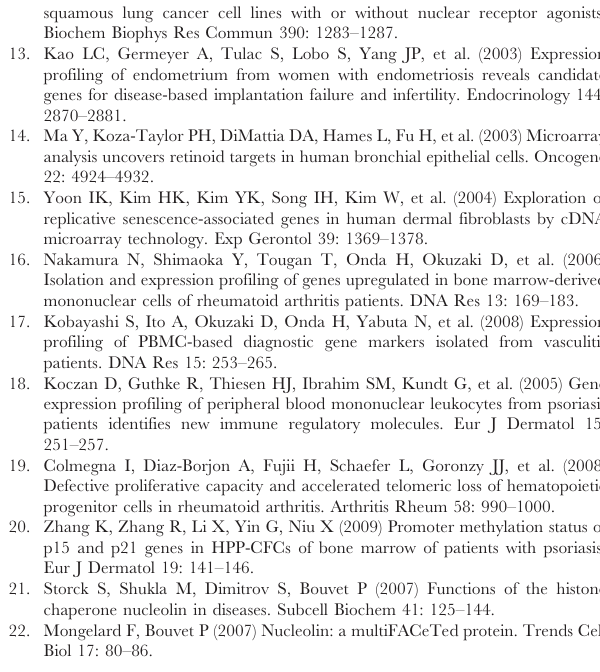
Figure S2 Cell cycle analysis of progenitor cells. LS 2 K cells were sorted from BM transplanted with MIGR1-G0S2 (A) or pSIREN-shG0S2 (B), fixed in 70% ethanol, and stained with Ki67 and 7-AAD ( n = 3–5). *, P , 0.05, and **, P , 0.01 (two-tailed Student’s t -test). Figure S3 Ectopic expression of G0S2 inhibits pro- liferation in EL4 cells and induced perinuclear seques- tration of nucleolin in resting HSCs. (A) Cell growth was analyzed in EL4 cells transduced with retroviruses MIGR1 or MIGR1-G0S2 ( n =3). **, P , 0.01 (two-tailed Student’s t -test). (B) Cell cycle analysis by DNA staining with propidium iodine. (C) LSK CD150 + CD48 2 BM cells isolated from B6 and 5-FU- injected B6 mice. Localization of nucleolin was determined by immunofluorescence.